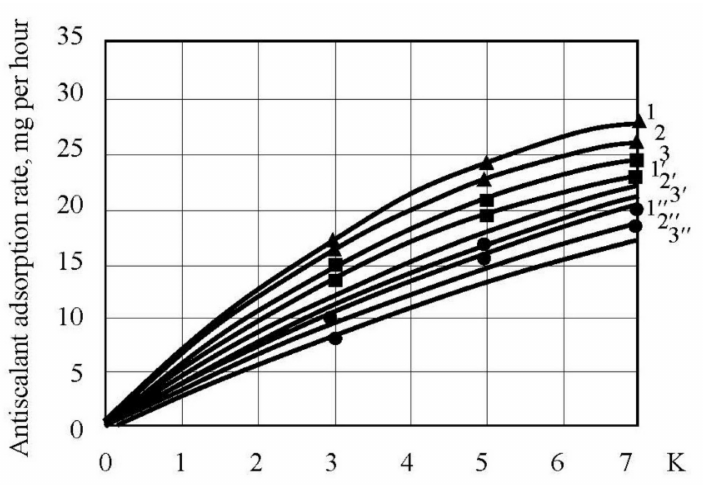
Figure 10. Results of evaluation of antiscalant adsorption rates: dependencies of adsorption rates on K.